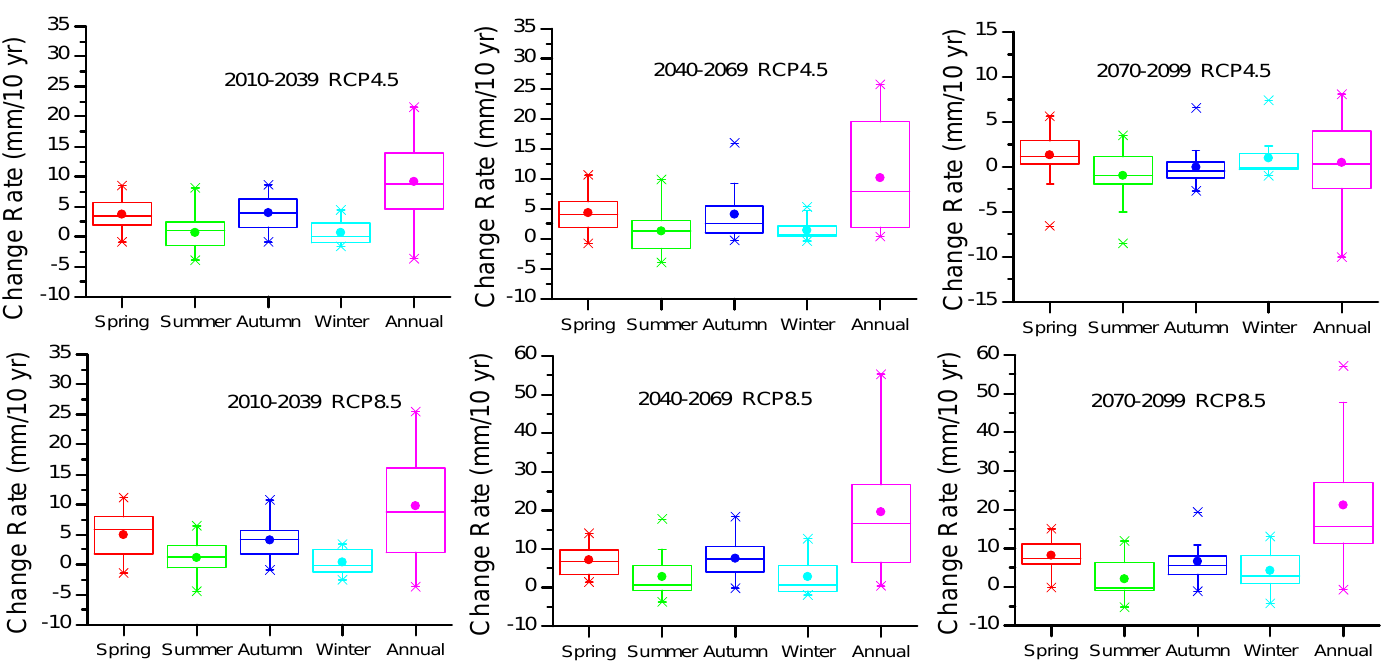
Figure 10. Boxplots for the change slope of future ET 0 at seasonal and annual scales calculated by the Sen Slope method.